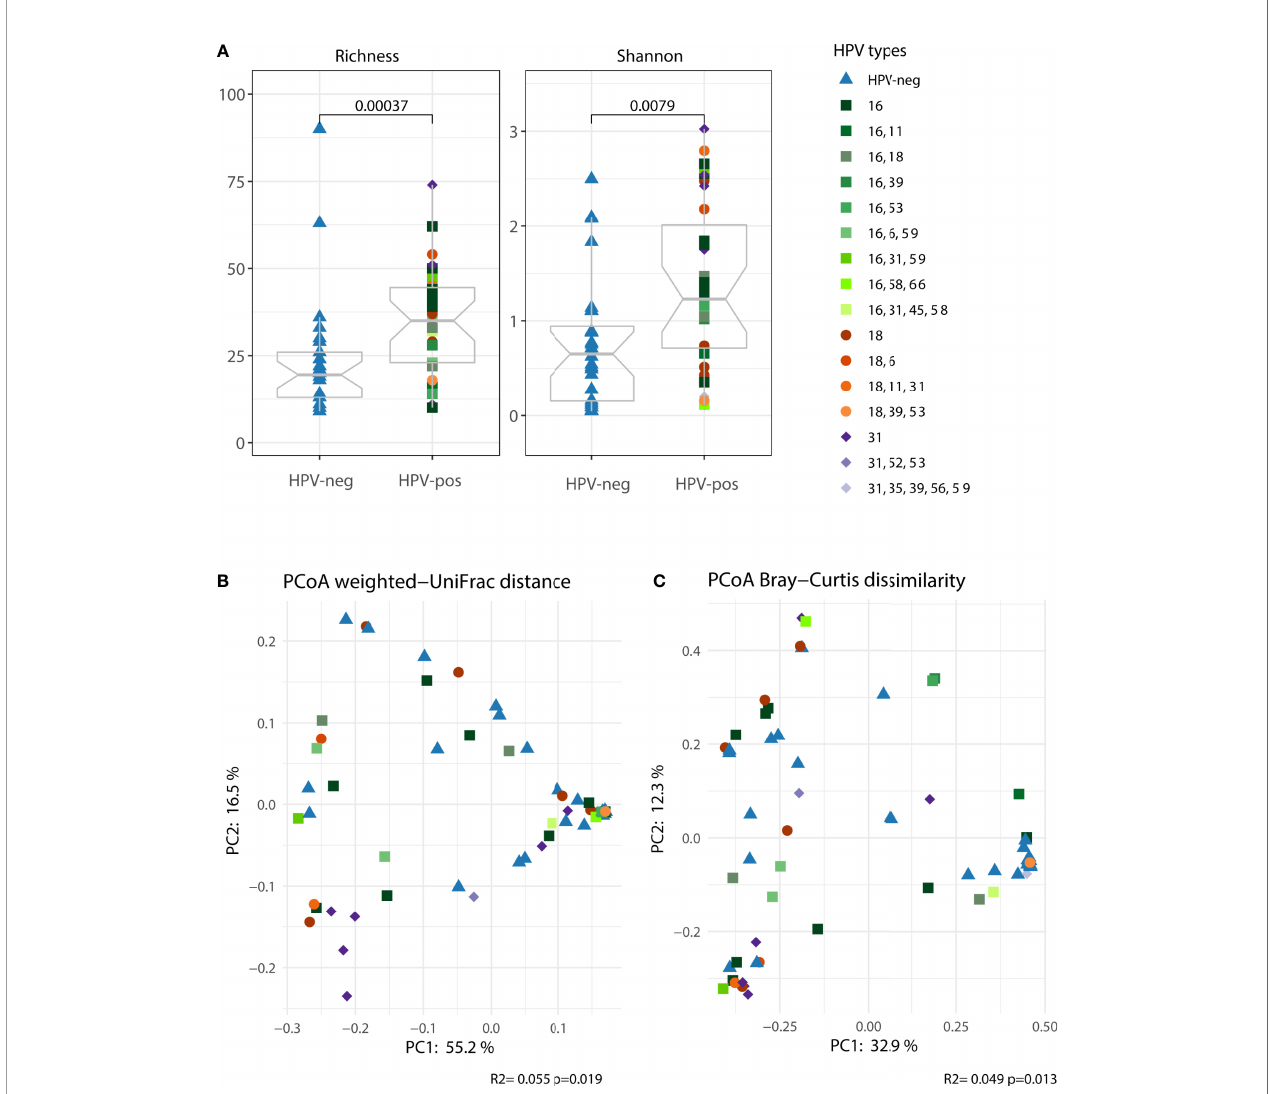
FIGURE 2 | The vaginal microbiota (cervicovaginal mucus) was characterized in women with symptomatic cervical ectopy with or without HPV infection. (A) Two alpha diversity indexes were calculated, richness (observed species) and shannon. Boxplots depicting the median and interquartile range strati fi ed by HPV infection. Groups were compared using the Wilcoxon Rank Sum test. Both weighted UniFrac (B) and Bray-Curtis dissimilarity (C) were used in conjunction with principal coordinate analysis (PCoA) to visualize microbial communities strati fi ed by HPV infection. Differences in beta diversity were assessed using permutational multivariate analysis of variance (PERMANOVA). Each point was colored according to the HPV type for HPV-pos women and order by the number of HPV types